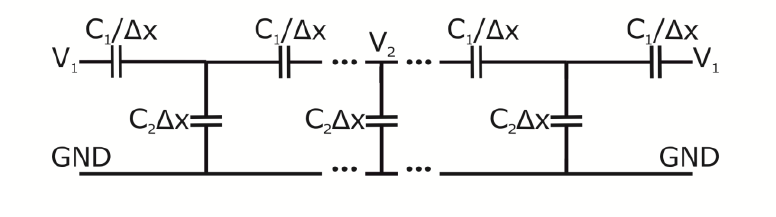
Figure 5. Simplified EEC of the LC